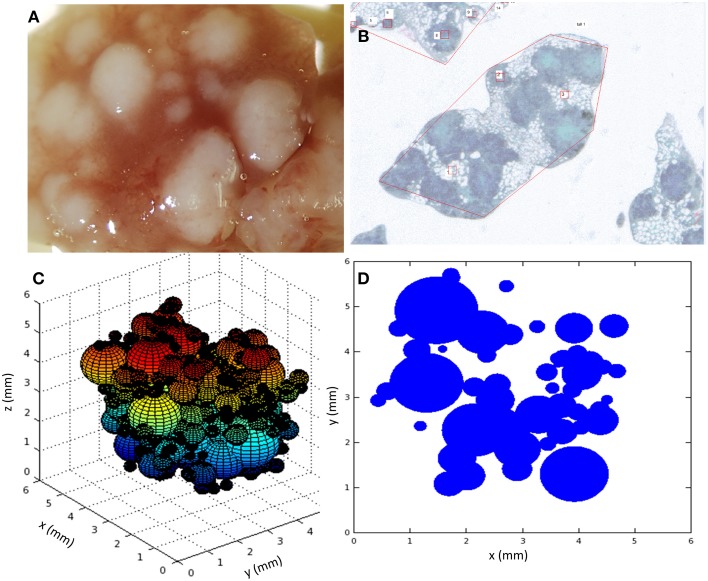
(A) Macroscopic image of the lung at day 30; (B) Microscopic image of paraffined slides of infected mice lungs; (C) snapshot of a 3D view of the simulation system, each sphere representing a lesion; (D) snapshot of a 2D slide of the simulation system, each circle representing a slide of a lesion. Simulations used parameters of panel B (Table 1).